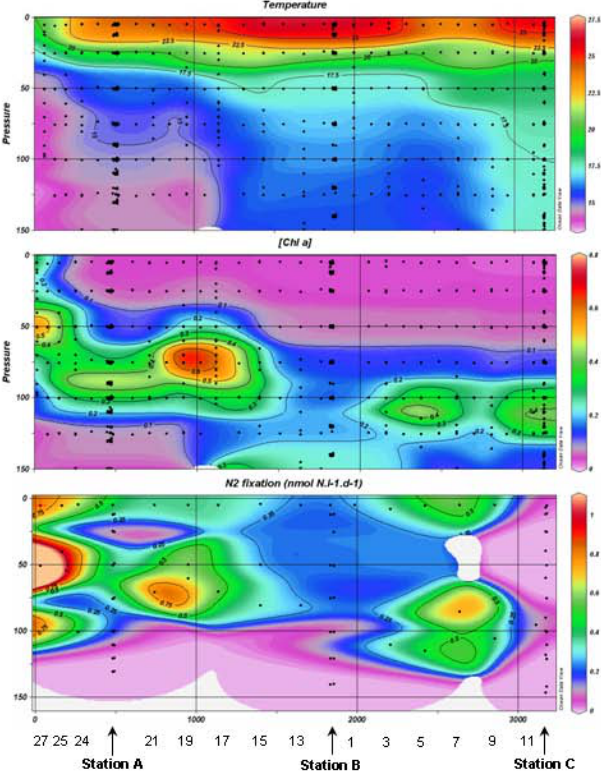
Fig. 2. Longitudinal cross section of N 2 fixation rates (nmoll − 1 d − 1 ) along the BOUM transect (0–160m) including fourteen SD stations and the three LD stations. X axis: distance in km from the station 27.